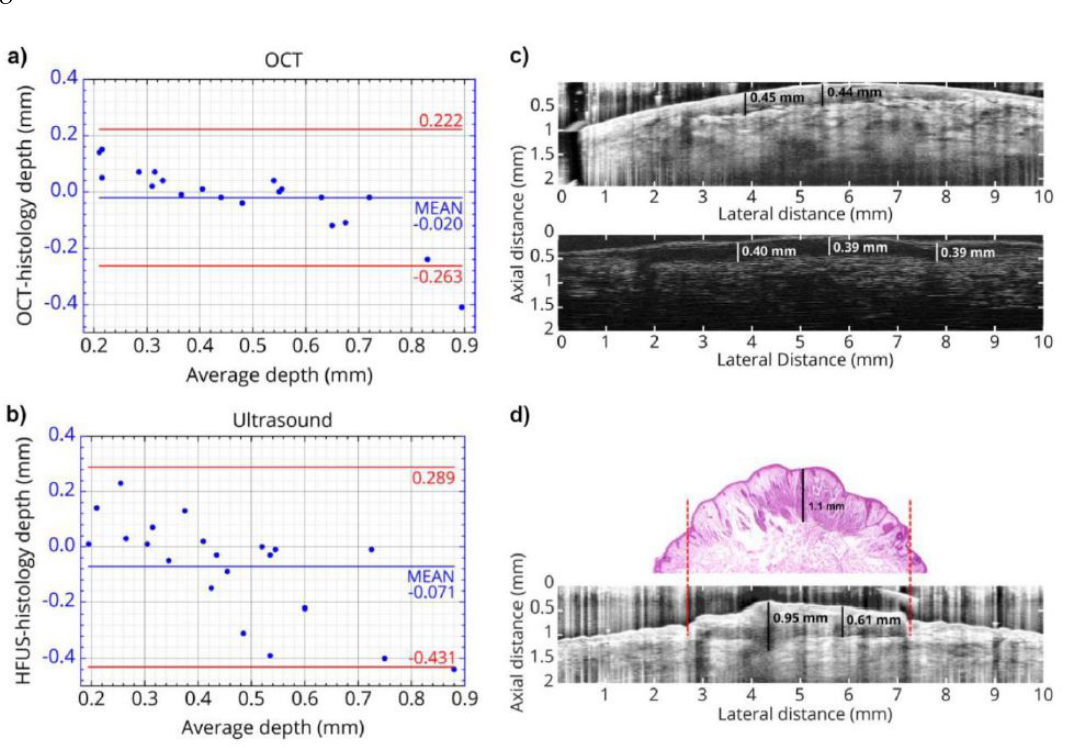
Figure 31. Determination of nevus thickness by OCT, HFUS, and histopathology. The Bland-Altman plots to the left describe the deviation of OCT ( a ) and HFUS ( b ) results from the nevus depth measured by histopathology. The top right pair of images ( c ) illustrate the appearance of a nevus viewed by OCT and HFUS, respectively. In the bottom right image ( d ), the stained histologicall slice is shown together with an OCT image of the same nevus with a thickness of approximately 1 mm visualizing also the deformations that can be induced by tissue preparation for histopathology. Corresponding regions for both modalities are marked by the red dashed lines (reproduced with permission from